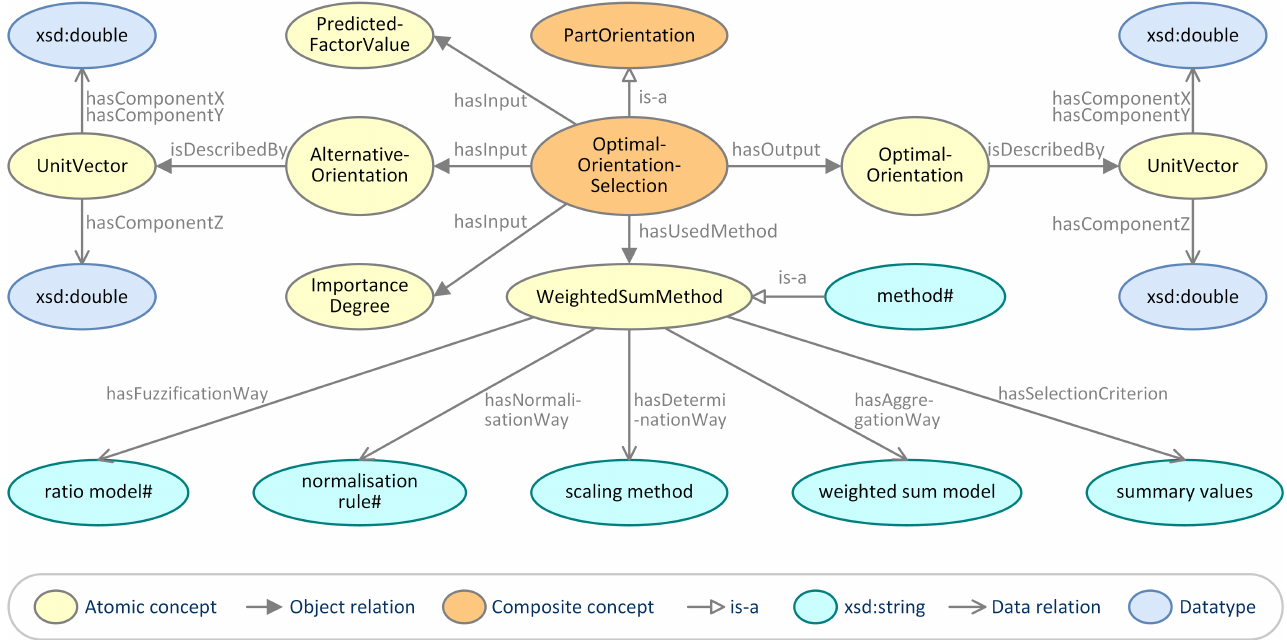
Figure 6. Ontological view of optimal orientation selection. # stands for in